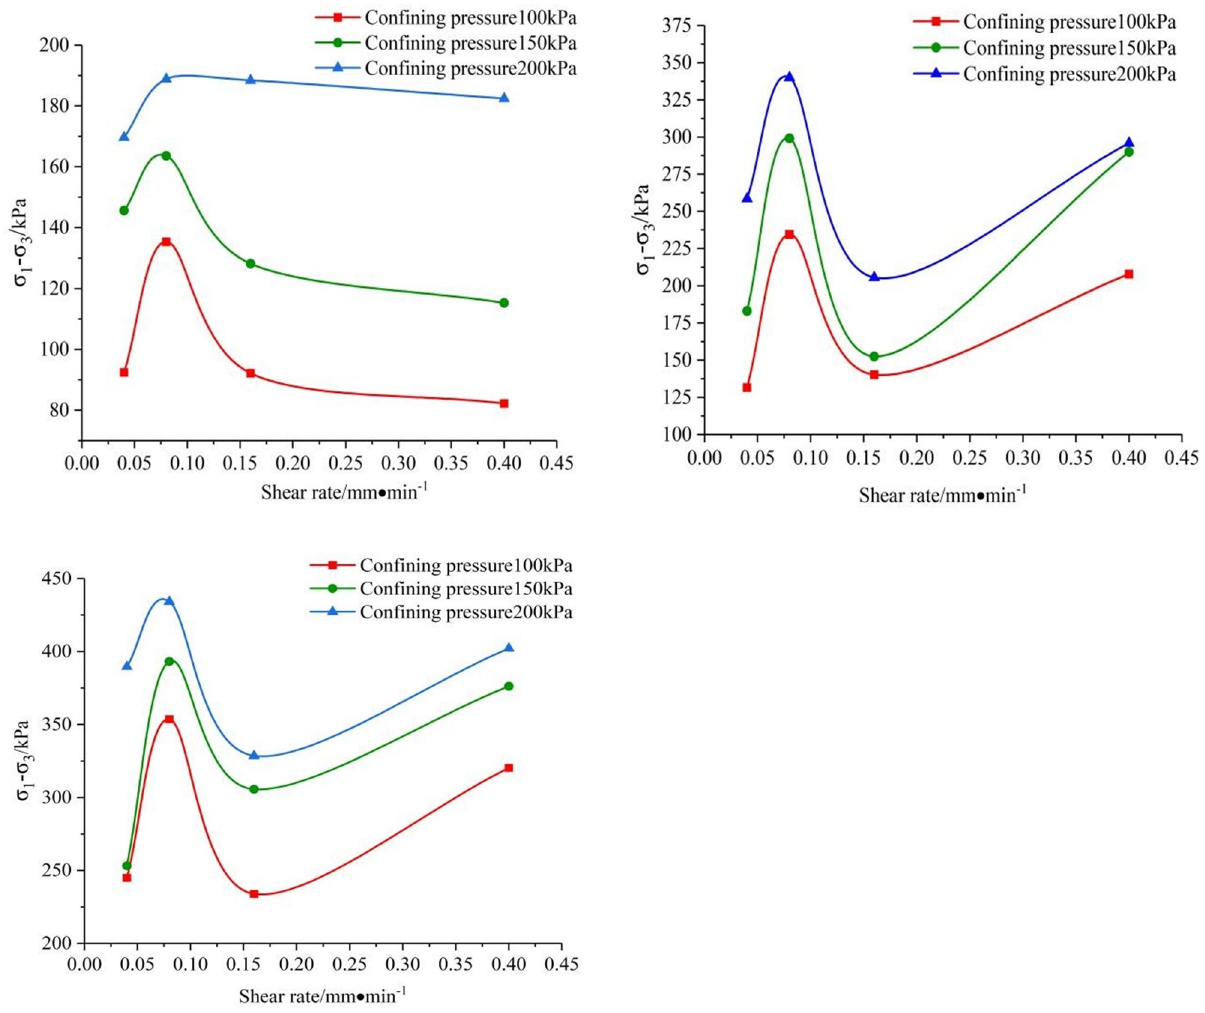
= 1.5 g/cm 3 . (b) ρ = 1.6 g/cm 3 . (c) ρ = 1.7 d d d